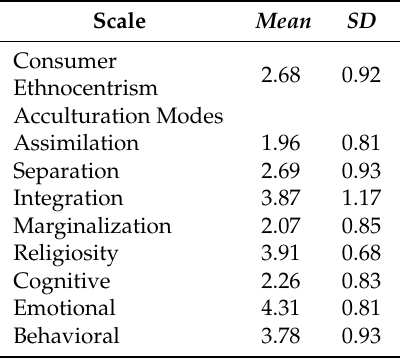
Table 1. Means and standard deviations of the